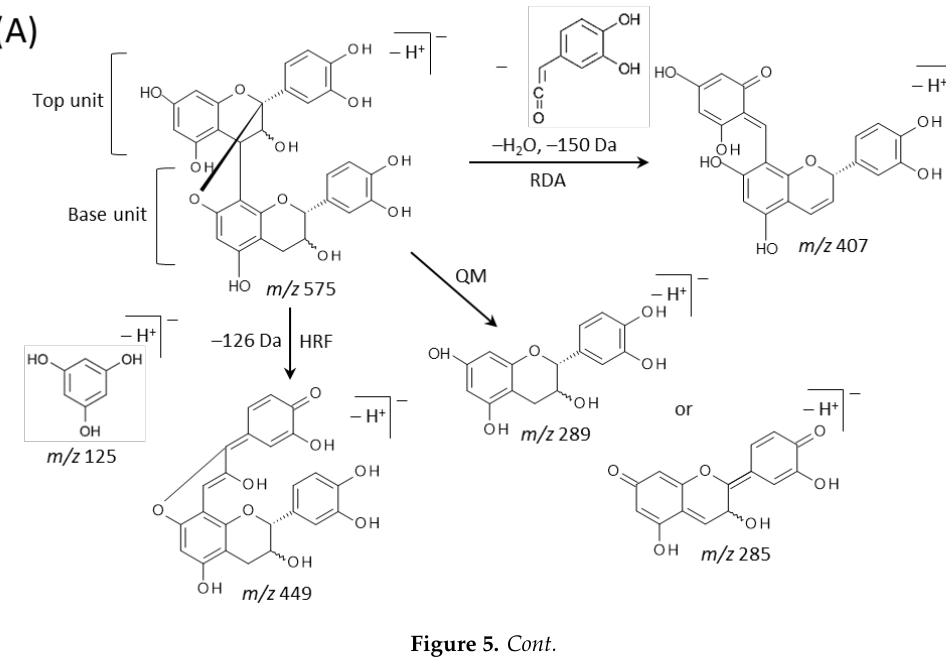
Figure 5. Cont. Figure 5.